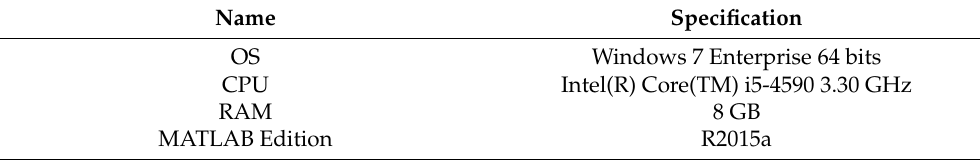
Table 1. Simulation equipment.